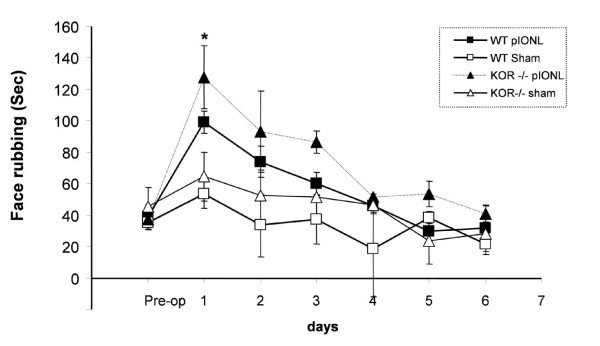
Face rubbing after pIONL. The total time for isolated face-rubbing episode during a 15 min observation period. The spontaneous face-rubbing behavior was recorded for 15 minutes on preoperative day 1 (baseline), and from postoperative day1 to day 6. The duration of face-rubbing behavior was elevated for both WT and KOR-/- pIONL groups on the first day after surgery compared to the baseline and sham operated groups. KOR-/- pIONL group showed longer duration of face-rubbing behavior than that of WT pIONL group on the postoperative day 1 (p < 0.05, ANOVA followed by Student-Newman test, n = 8 per group). The duration of face-rubbing behavior peaked at postoperative day 1 and this increased facial rubbing gradually recovered to the basal level.